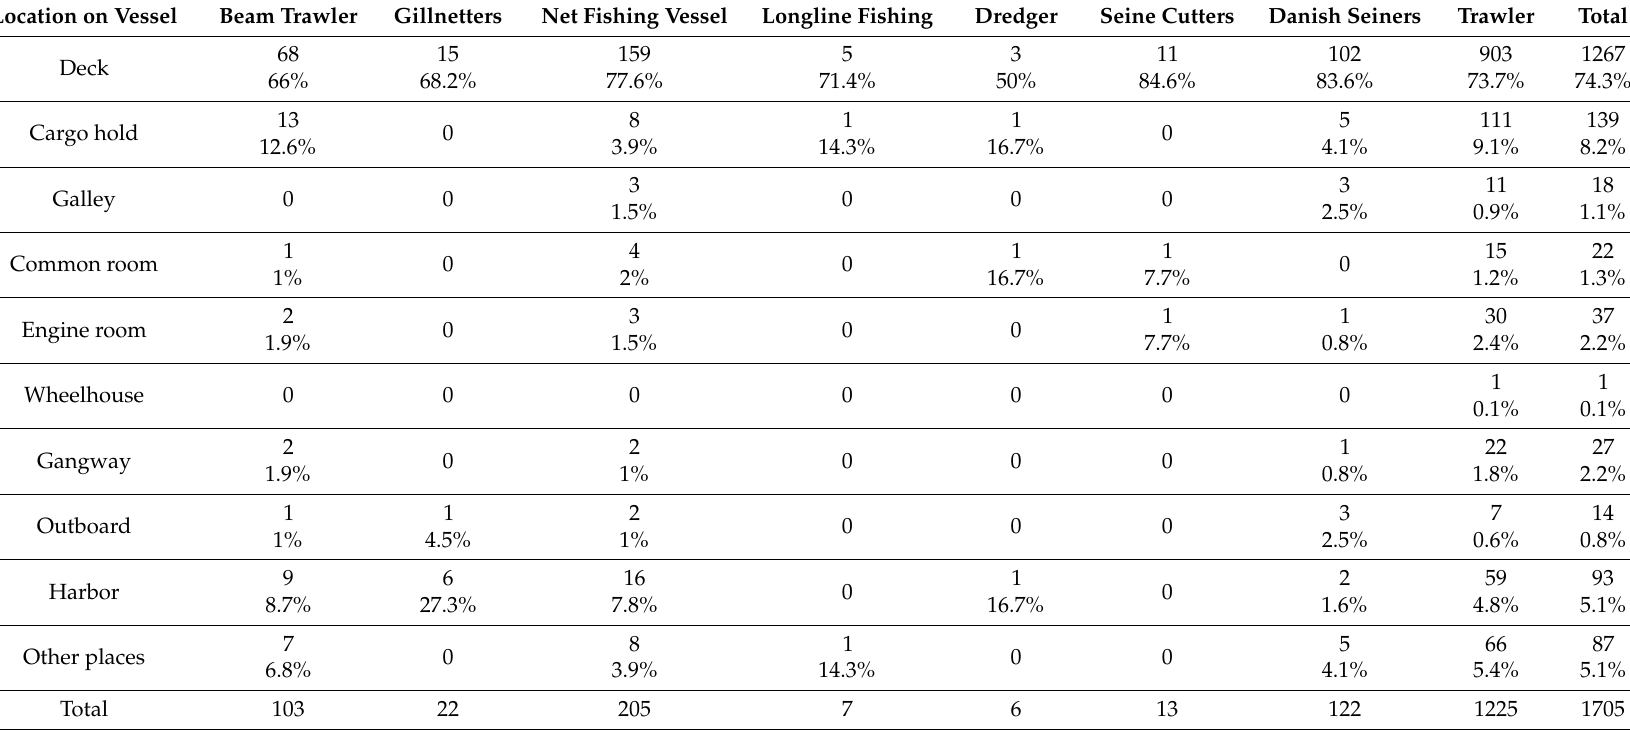
Table 5. Distribution and place of reported injuries (in number and percentage) among different types of vessels in the period 1998–2016. Location on